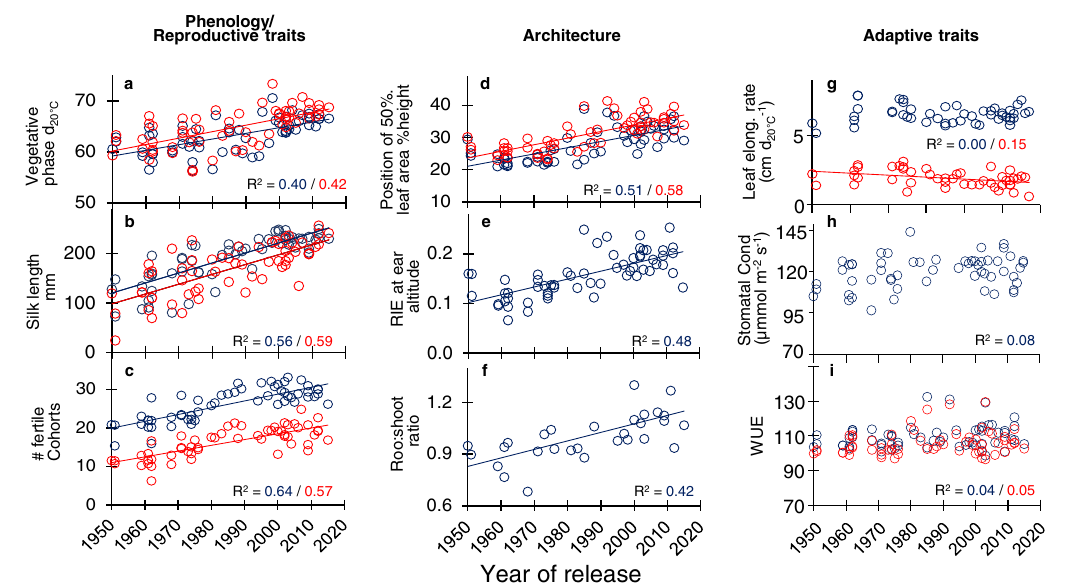
Fig. 5 Phenological, reproductive, and architectural traits changed with year of release similarly in all environmental conditions; adaptive traits did not. a Duration of the vegetative period. b Mean silk length at anthesis (from insertion point to silk apex). c Number of fertile grain cohorts per plant. d Distance, from top of the canopy, of the layer with 50% of total leaf area, in % of canopy height. e Amount of light intercepted by the canopy layer where ears are located, normalized by incident light (unitless). f Root:shoot ratio (unitless). g Leaf elongation rate (LER). h Whole-plant stomatal conductance. i Water-use ef fi ciency. Blue dots, well-watered plants (soil water potential > − 0.1 MPa) and red dots, water de fi cit (soil water potential < − 0.1 MPa). Each dot is the BLUE value corresponding to one hybrid. Origin of data: a Exp i, j, l, m (Supplementary Table 2); b platform Exp a. c Exp i, j, l, m. d , e platform Exp a. f platform Exp h; g platform experiments d to f. h platform Exp g. i platform Exp a. See Supplementary Figs. 4 and 5 for other experiments. Regression lines are drawn when slopes are signi fi cant ( p < 0.01). Source data and p -values in Supplementary data